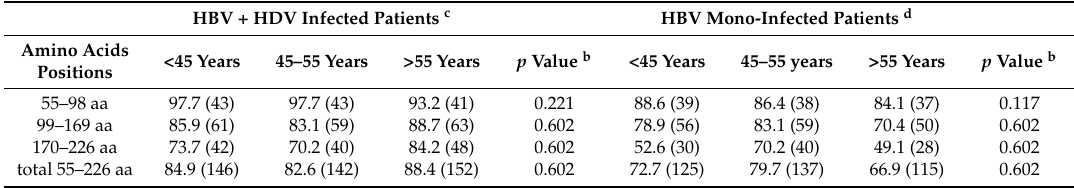
Table 3. Percentage ( n ) of HBsAg conserved residues by stratifying patients according to age a